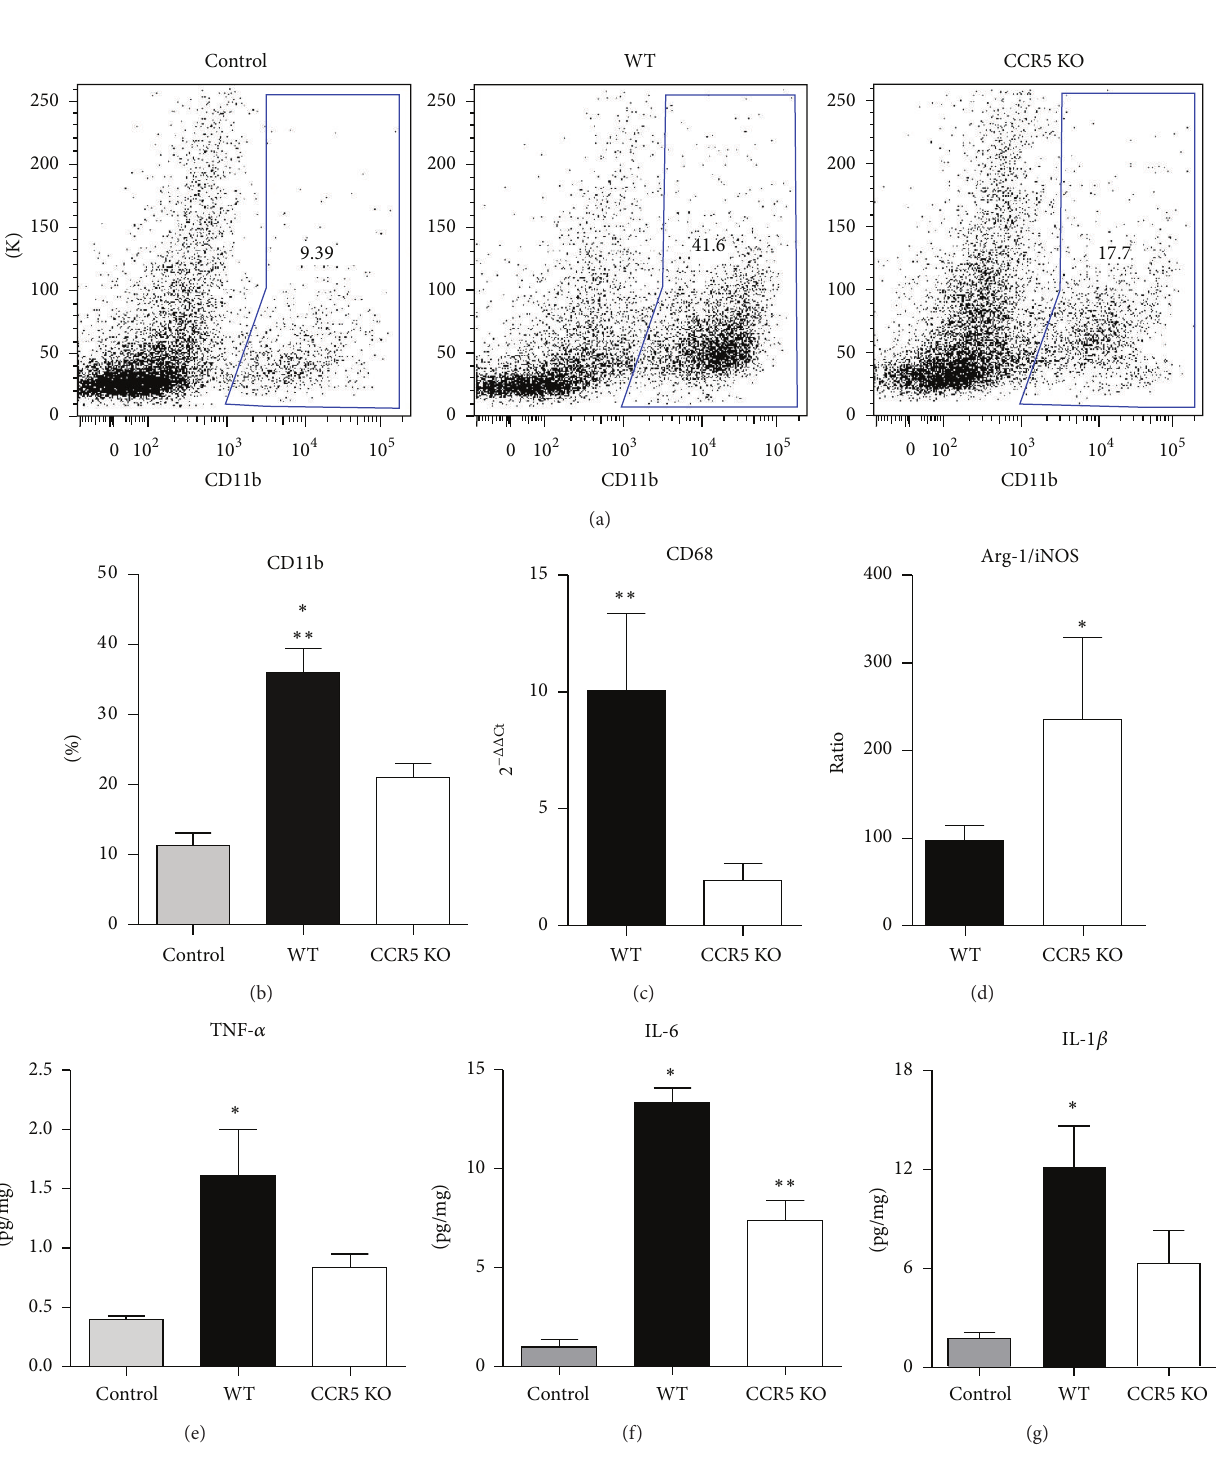
Figure 5: Macrophage recruitment in renal tissue is reduced in CCR5 KO animals, leading to less inflammation. (a) Representative image of the macrophage infiltration in the kidney, evaluated by CD11b positive cells. In panel (b) we can observe the quantification of the total data from panel (a) ( ∗ 𝑃 < 0.01 versus Control and ∗∗ 𝑃 < 0.05 versus CCR5 KO group). The gene expression of CD68 and the ratio regarding the mRNA levels of arginase-1/iNOS can be checked at panels (c) and (d), respectively ( ∗∗ 𝑃 < 0.05 versus CCR5 KO and ∗ 𝑃 < 0.05 versus WT). Also, the protein levels of the proinflammatory molecules TNF- 𝛼 , IL-6, and IL-1 𝛽 were evaluated in the same animals and the results are shown in panels (e), (f), and (g), respectively ( ∗ 𝑃 < 0.05 versus control and CCR5 KO groups and ∗∗ 𝑃 < 0.05 versus